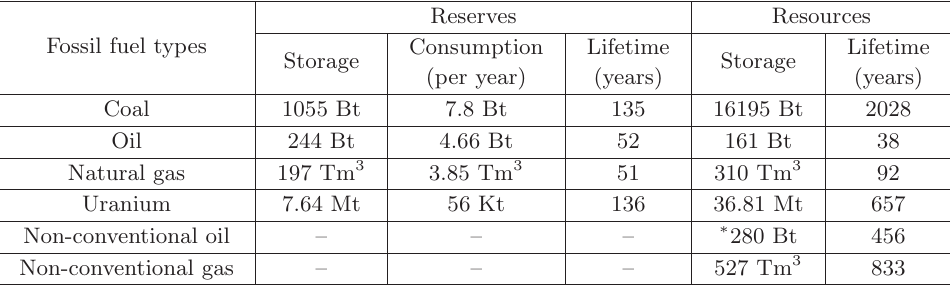
Table II. – Different fossil reserves and resources along with their projected lifetimes, taking their current storage levels and rate of usage into account [22-26] .